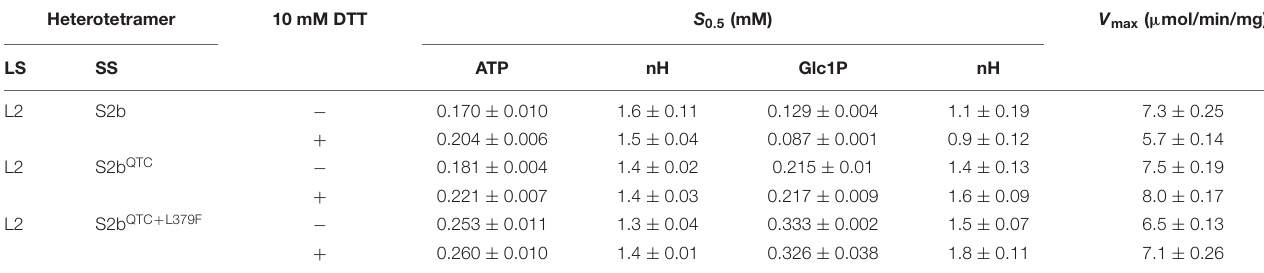
TABLE 2 | Substrate affinities and reductive activation of AGPases.